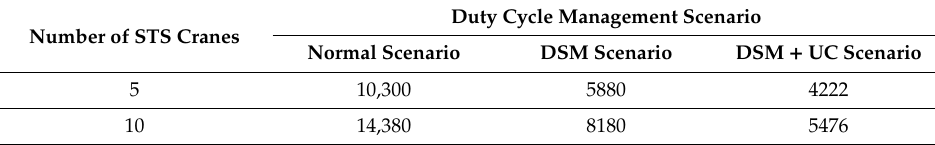
Table 5. Rated Pmax in different scenarios for the group of STS cranes [kW].